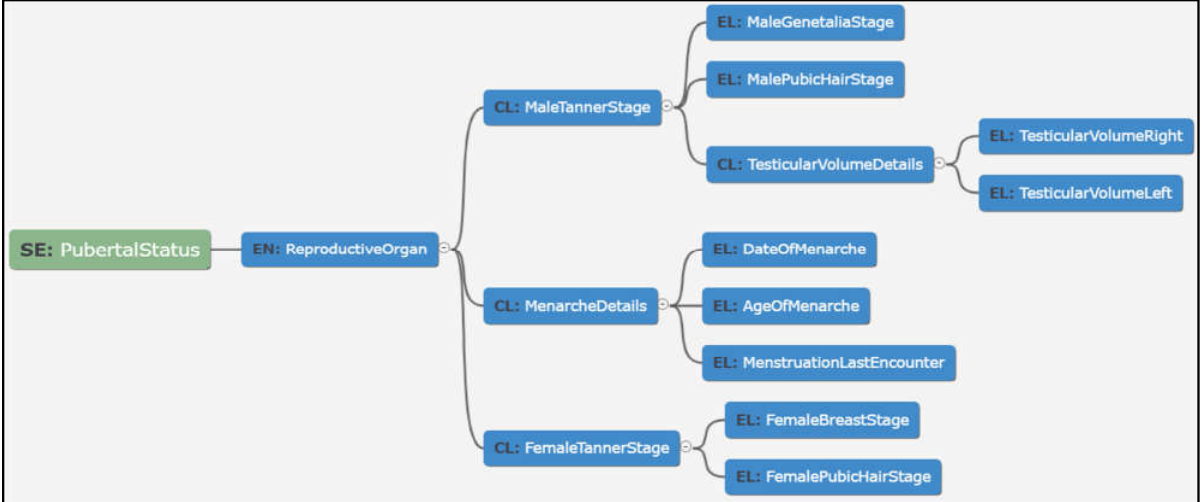
Figure 5. Example of modelling pubertal status concepts.